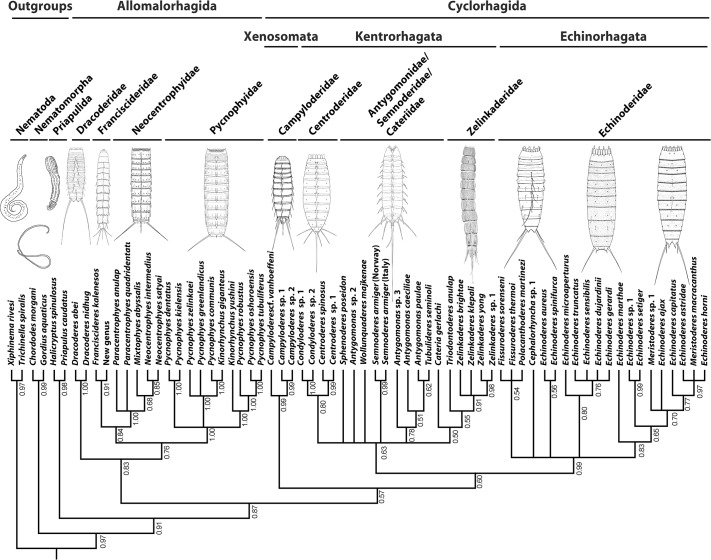
Combined morphological and molecular tree.Tree resulting from Bayesian Inference of combined morphological and molecular data sets. Numbers at branches indicate posterior probabilities.